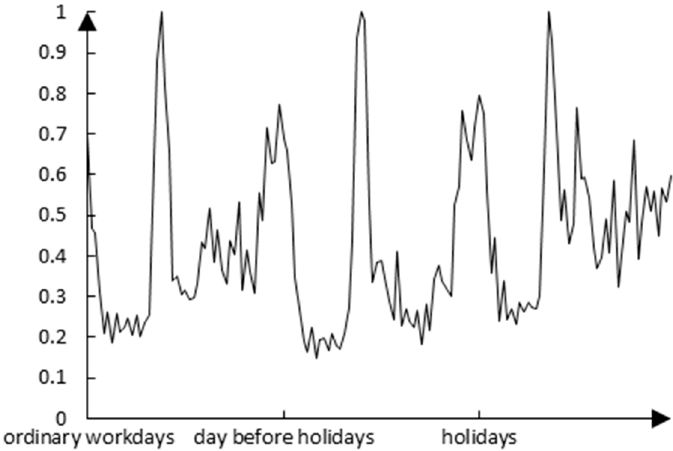
Figure 4. The normalized load curve of a domestic user.